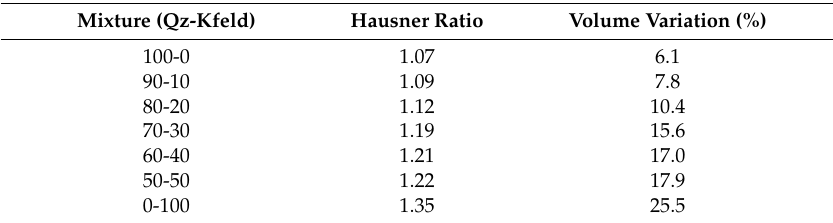
Table 5. Hausner ratio and volume variation, in percentage, for the different granular mixtures (see text for details).